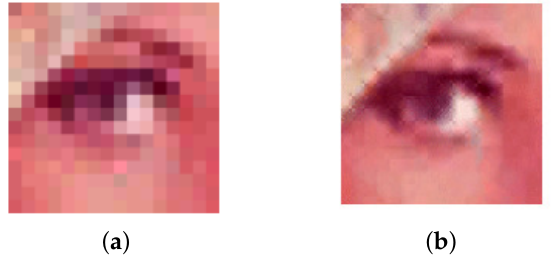
Figure 36. Resolution independence: ( a ) Original image enlarged 4 times, ( b ) Decoded